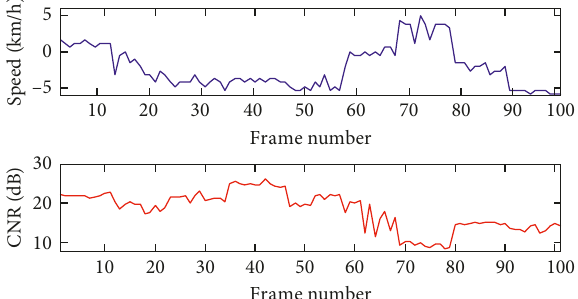
Figure 14: Results of CNR and relative Doppler speed in Test 2.